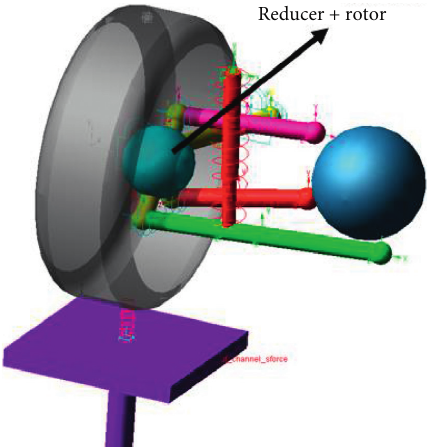
Figure 7: Dynamics model of the wheel motor drive system with the same suspension